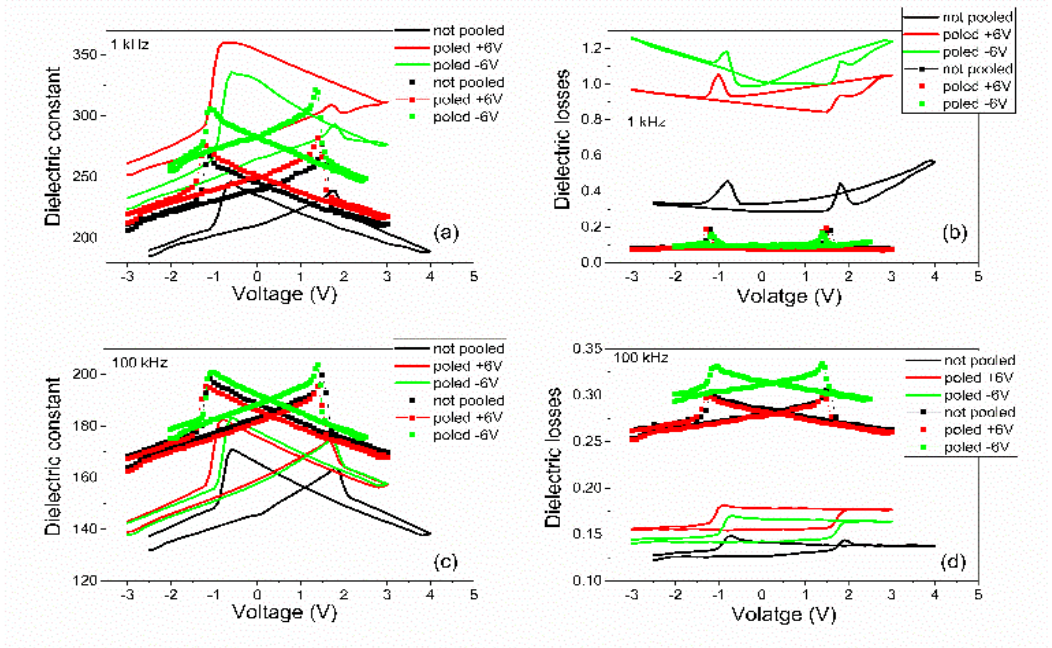
Figure 5. The voltage dependence of the dielectric constant as extracted from the C–V characteristics and the voltage dependence of the dielectric losses, obtained for PZT films grown from commercial target (lines) and from pure target (markers). Measurements performed at 300 K using an ac voltage of 0.1 V amplitude and ( a , b ) 1 kHz frequency and for ( c , d ) 100 kHz.